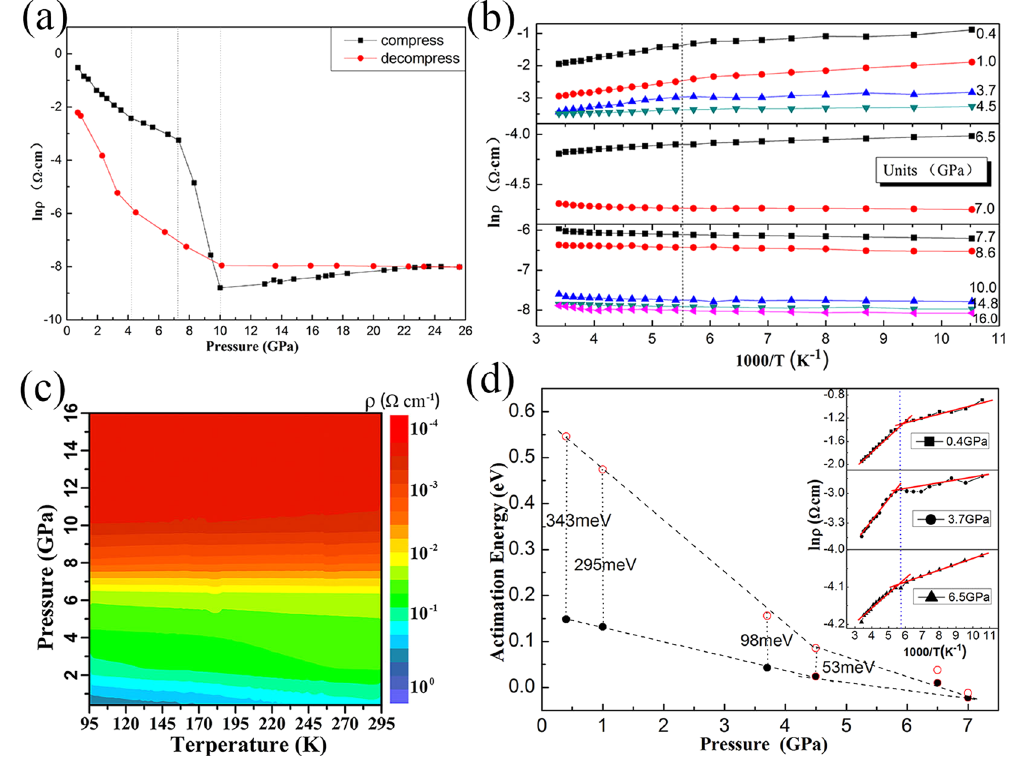
Figure 2. ( a ) Pressure dependence of electrical resistivity of GaSb at room temperature, dashed line positions indicate discontinuous pressure; ( b ) Temperature-resistivity curves at different pressure; ( c ) Temperature- pressure-resistivity contour map; ( d ) Pressure dependence of activation energy of GaSb in two different temperature regions: between 185 K and room temperature (solid circle), between 70 and 185 K (open circle). The inset shows the plots of ln ρ vs 1000/T at 0.4, 3.7, and 6.5